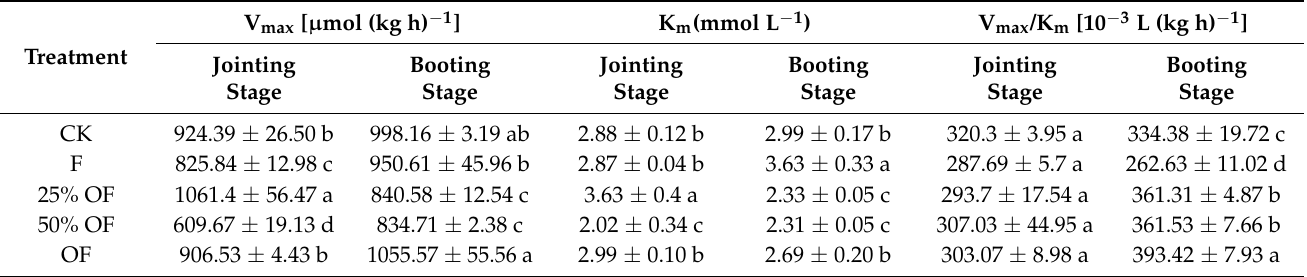
Table 2. Kinetic parameters of β –glucosidase in soil under different fertilization treatments.